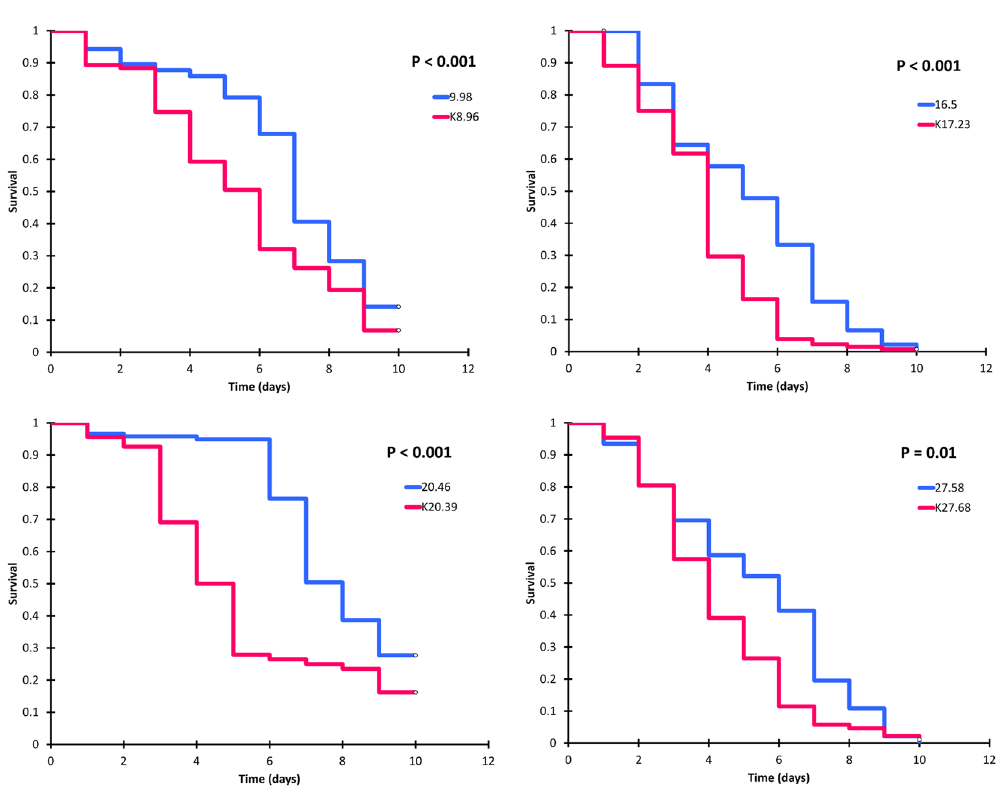
Figure 4. Survival curves of mosquitoes feeding on blood with matching ivermectin concentrations ( + / − 1 ng/ ml) with (blue) or without (pink) the ketoconazole at CYP inhibition concentrations. Triplicate experiments, n =